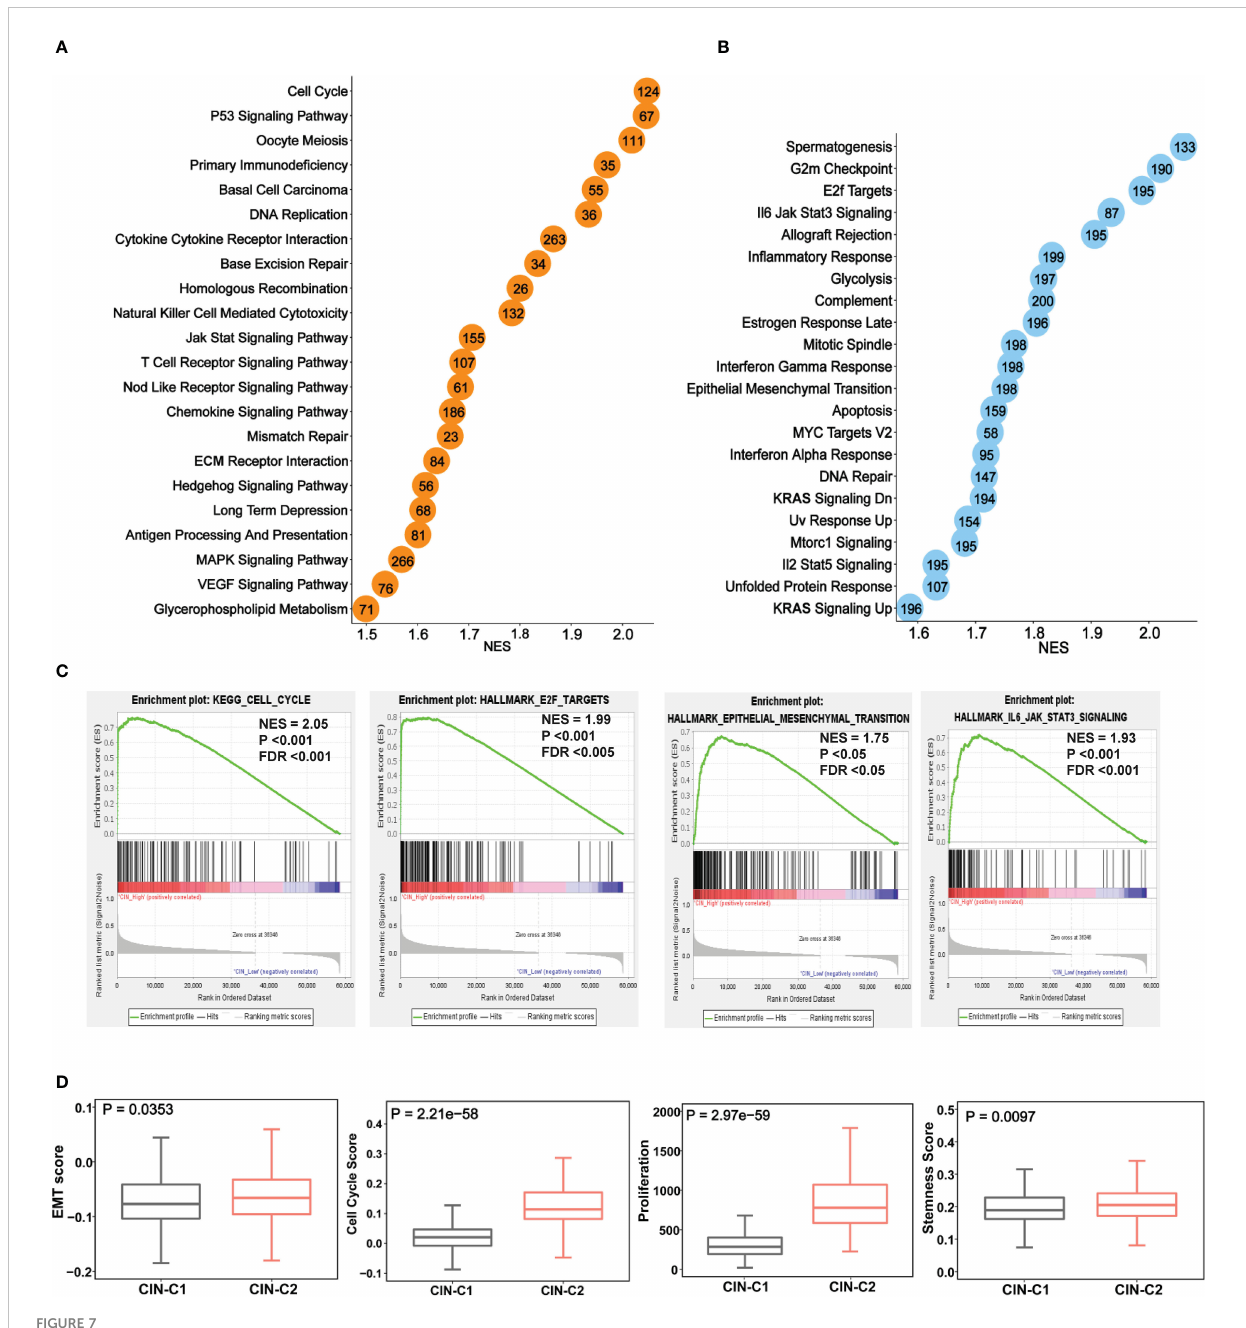
FIGURE 7 The enriched oncogenic pathways and aggressive phenotypes in the CIN25-C2 subtype of ccRCC tumors. The TCGA cohort analysis. (A, B) Enrichments of overrepresented KEGG (A) and hallmark (B) pathways in CIN25-C2 tumors. (C) Representative enriched pathways in CIN25-C2 tumors: Cell cycle, E2F targets, EMT and IL6-JAK-STAT3. (D) Higher EMT, proliferation and stemness scores in CIN-C2